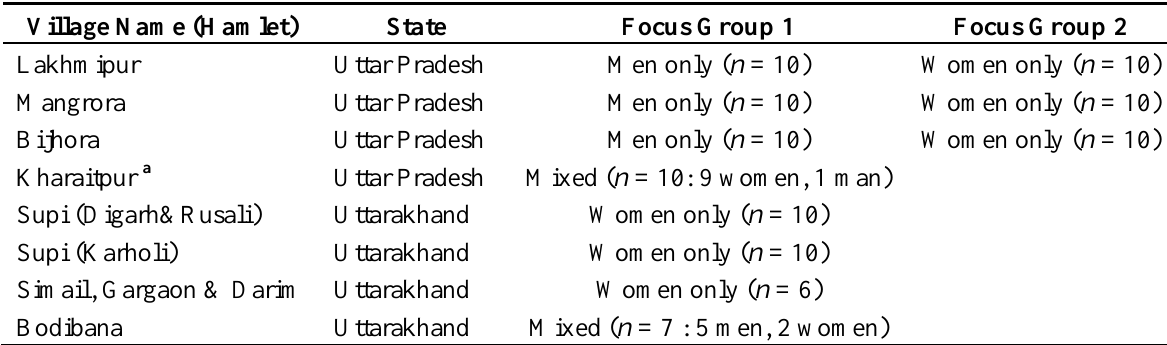
Table 1. Focus group locations and